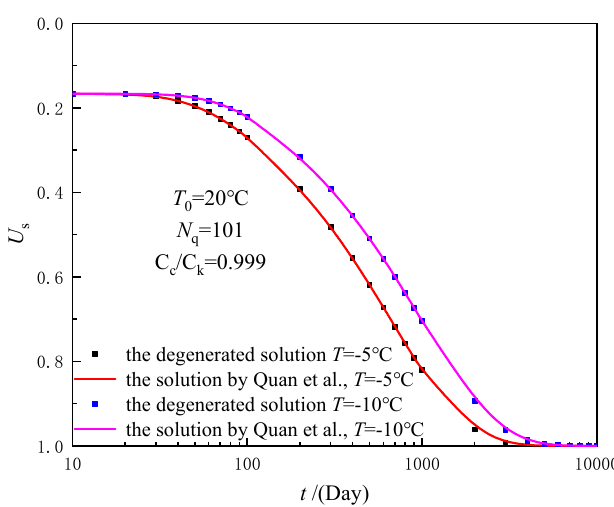
Figure 2. Comparisons between the solution by Quan et al. [43] and the present degradation solution.